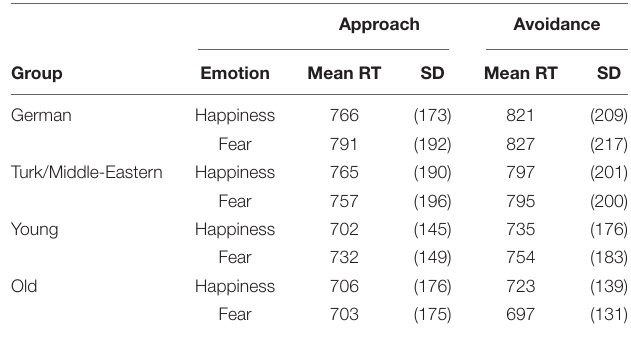
the impression that it walked toward or away from the emotional expression. After three key-presses, the screen turned